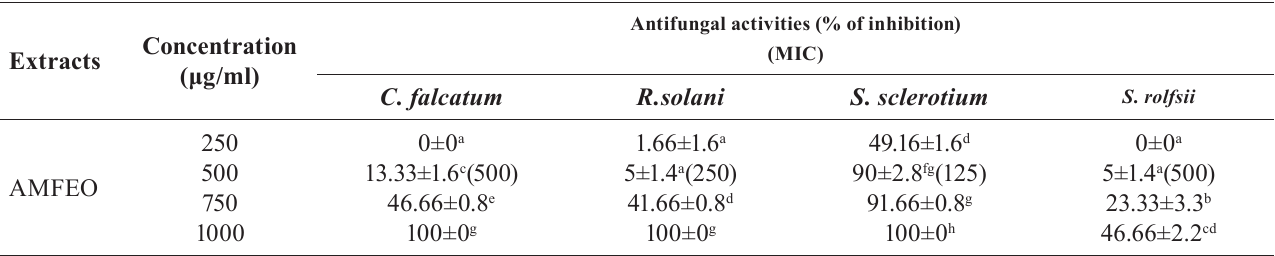
Values are means of three replicates± SE. Within a column, mean values followed by the same letter are not significantly different according to Tukey’s test